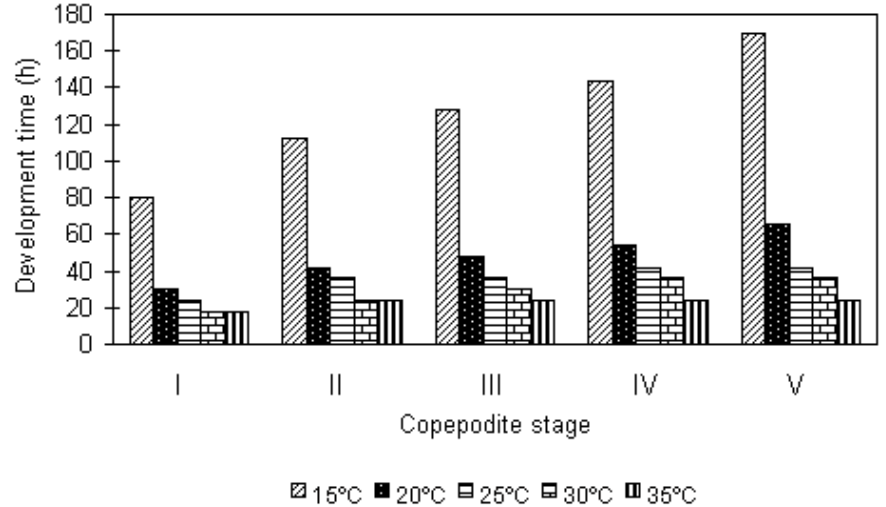
FIGURE 2. Development time of copepodites of P. dubia under different